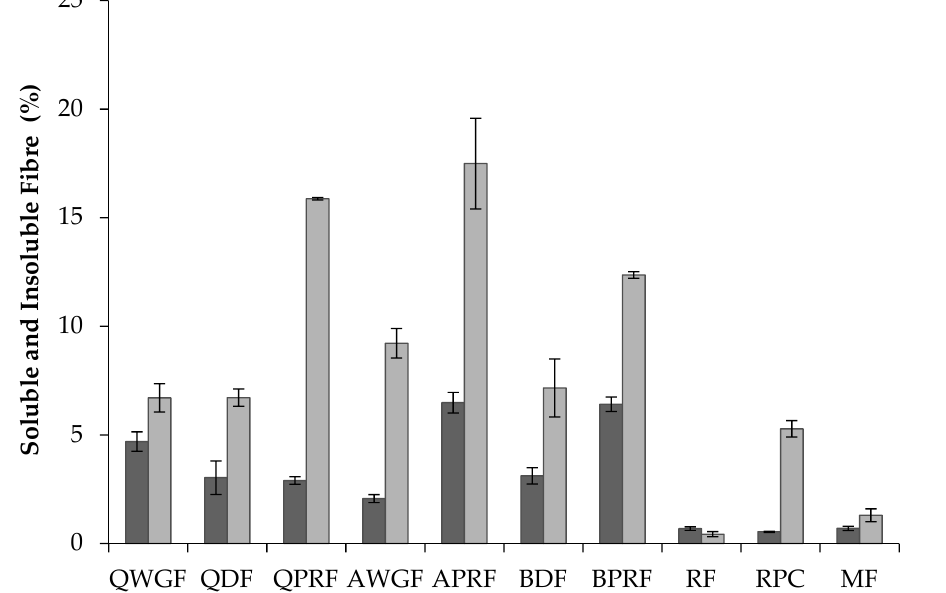
Figure 2. Soluble ( ) and insoluble ( ) dietary fibre content (% w / w ) of quinoa wholegrain flour (QWGF), quinoa dehulled flour (QDF), quinoa protein-rich flour (QPRF), amaranth wholegrain flour (AWGF), amaranth protein-rich flour (APRF), buckwheat dehulled flour (BDF), buckwheat protein- rich flour (BPRF), rice flour (RF), rice protein concentrate (RPC), and maize flour (MF).